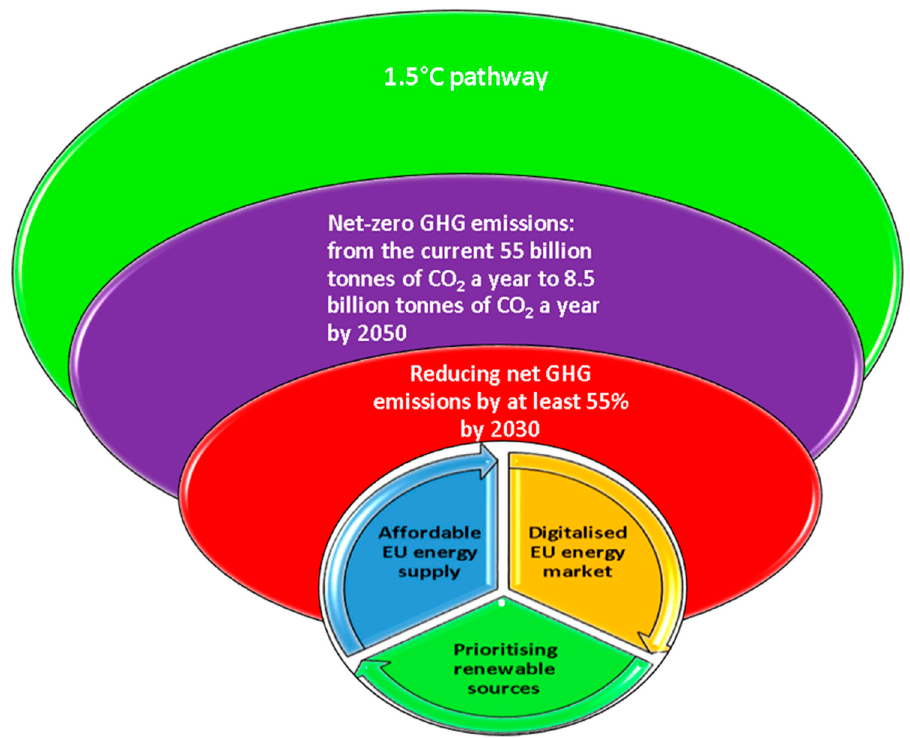
Figure 1. Trajectory toward decarbonizing the EU’s energy system.